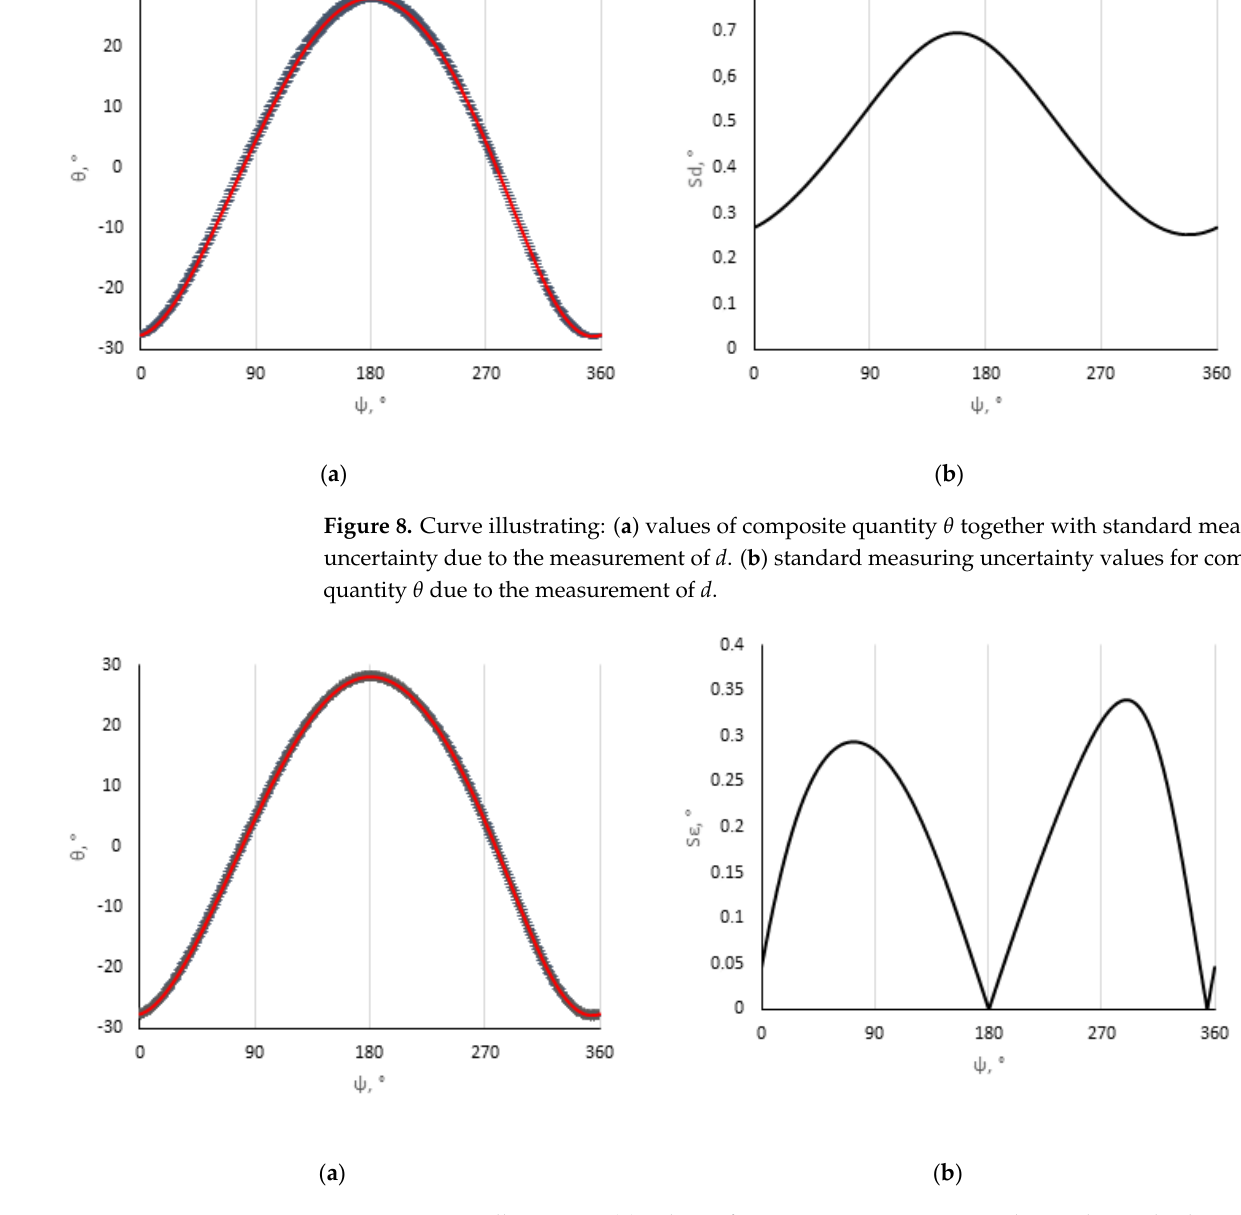
Figure 9. Curve illustrating: ( a ) values of composite quantity θ , together with standard measuring uncertainty due to the measurement of ε . ( b ) standard measuring uncertainty values for composite quantity θ due to the measurement of ε .